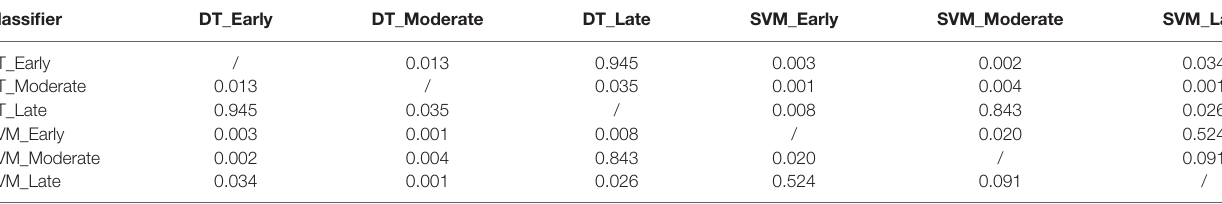
DT, decision tree; SVM, support vector machine. The symbol ("/") represents null.